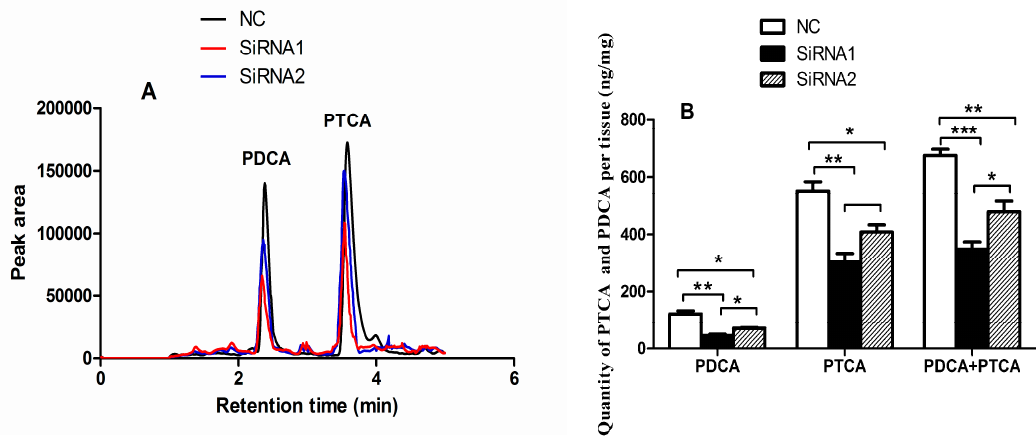
Figure 6. LC-MS/MS analysis of oxidation products of melanin in P. penguin . ( A ) HPLC (High Performance Liquid Chromatography) chromatograms of oxidation products of melanin from NC group and RNAi groups. ( B ) The content of PDCA and PTCA from NC group and RNAi groups. Each bar was a mean of 6 pearl oysters. * meaned significant difference ( P < 0.05); ** meaned very significant difference ( P <0.01); *** meaned extremely significant difference ( P <0.001).